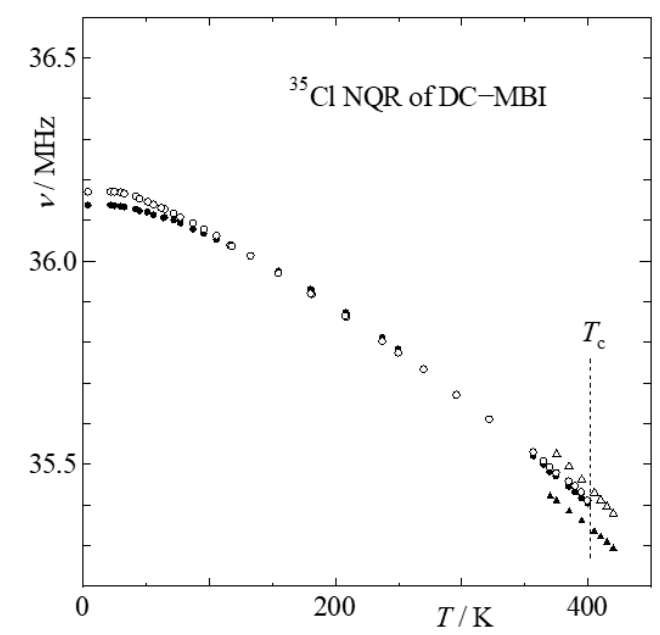
Figure 2. Powder X-ray di ff raction of DC-MBI crystal taken at room temperature using Cu K α radiation. Theoretical pattern was calculated for Pca 2 1 , a = 14.238(3), b = 5.6866(12), c = 10.398(2) Å, Z = 4 at 295 K [1].